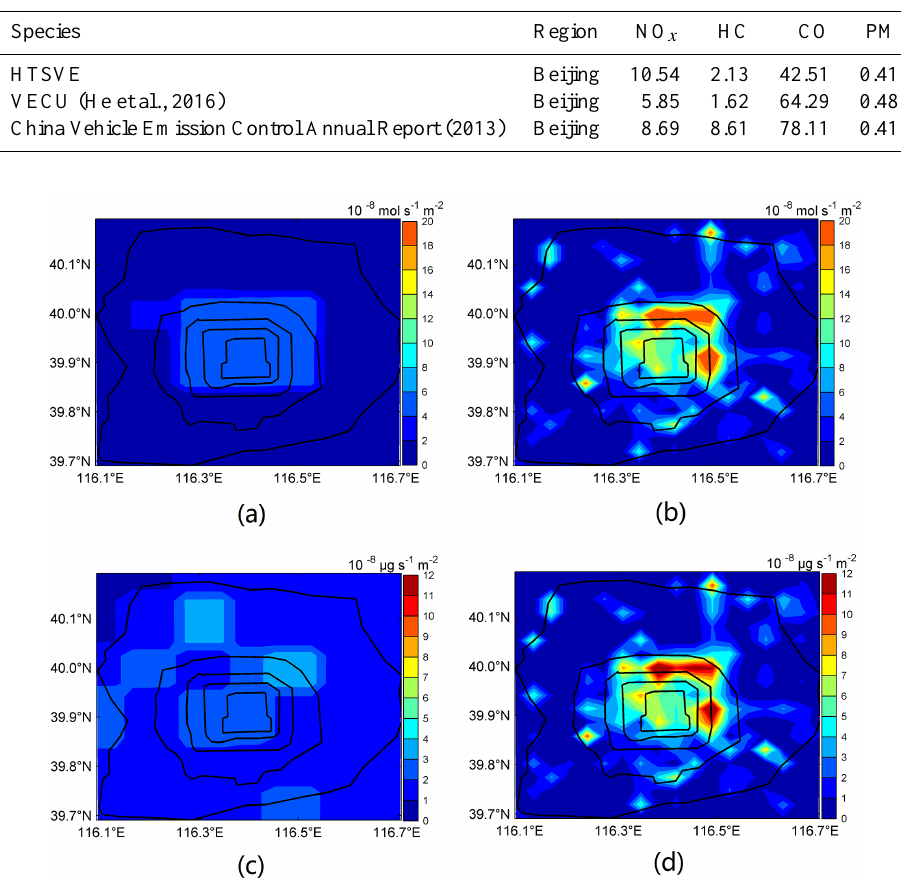
Figure 9. Spatial distributions of vehicle emissions in Beijing urban core area: (a) NO x emissions in VECU, (b) NO x emissions in HTSVE, (c) PM emissions in VECU and (d) PM emissions in